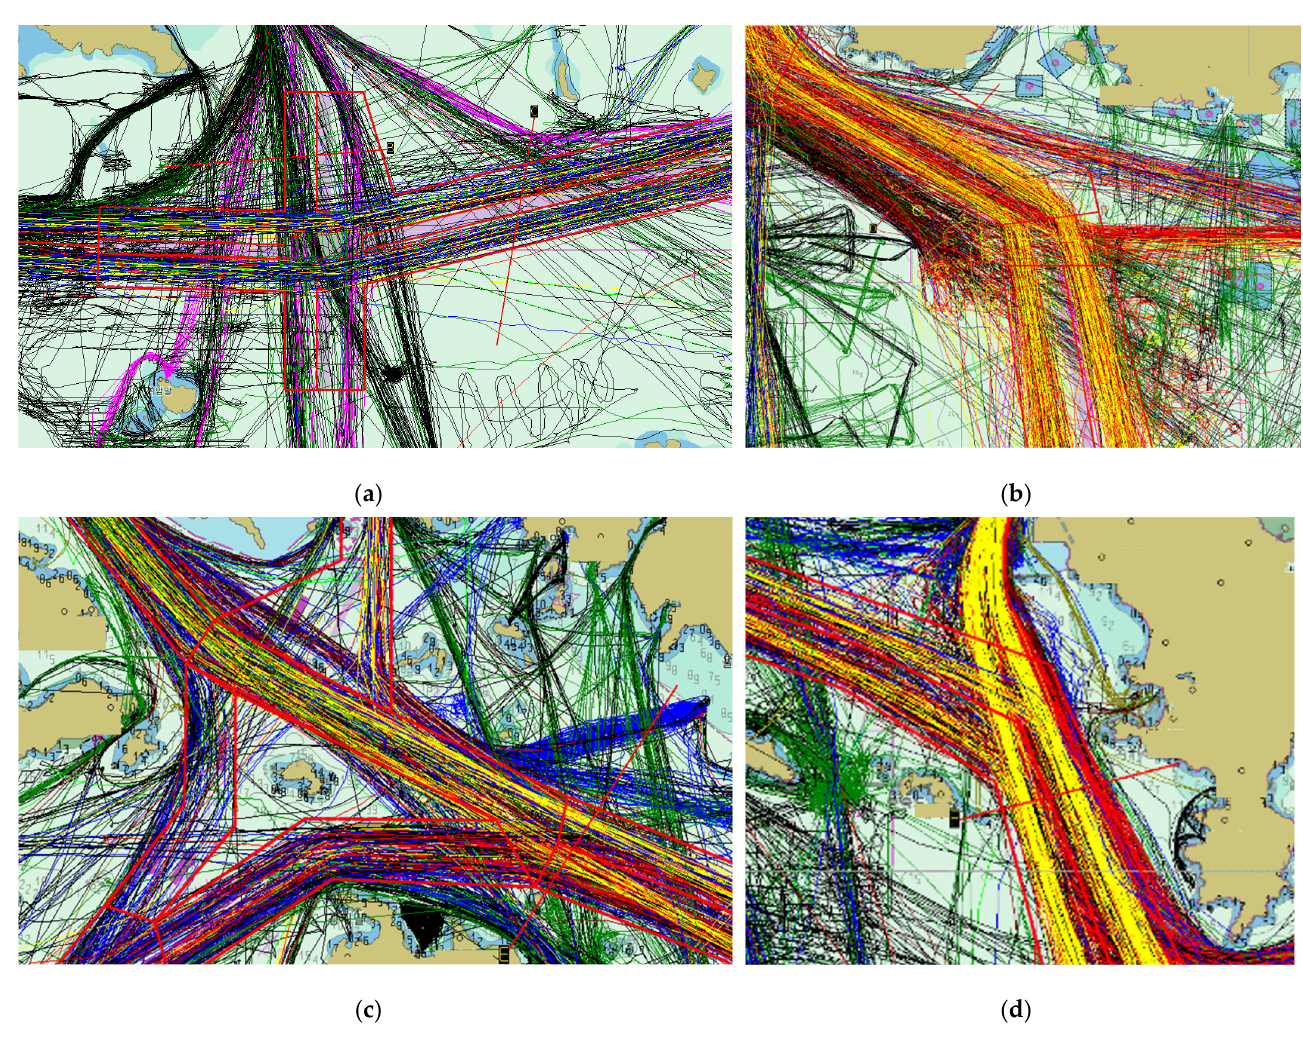
Figure 4. ( a ) Maritime traffic flow in the entrance and crossing fairways near Wando Port, ( b ) maritime traffic flow in the Yeosu area in specific traffic safety waters, ( c ) maritime traffic flow in the Masan fairway, and ( d ) maritime traffic flow in the Gadeok fairway.